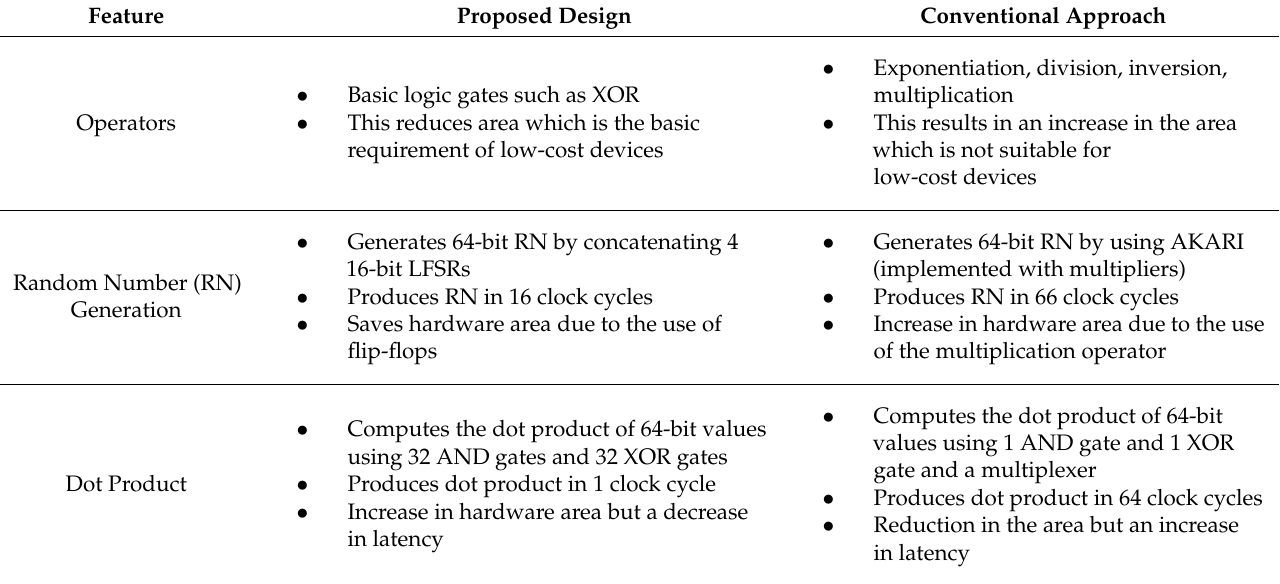
Table 3. Features of the key exchange